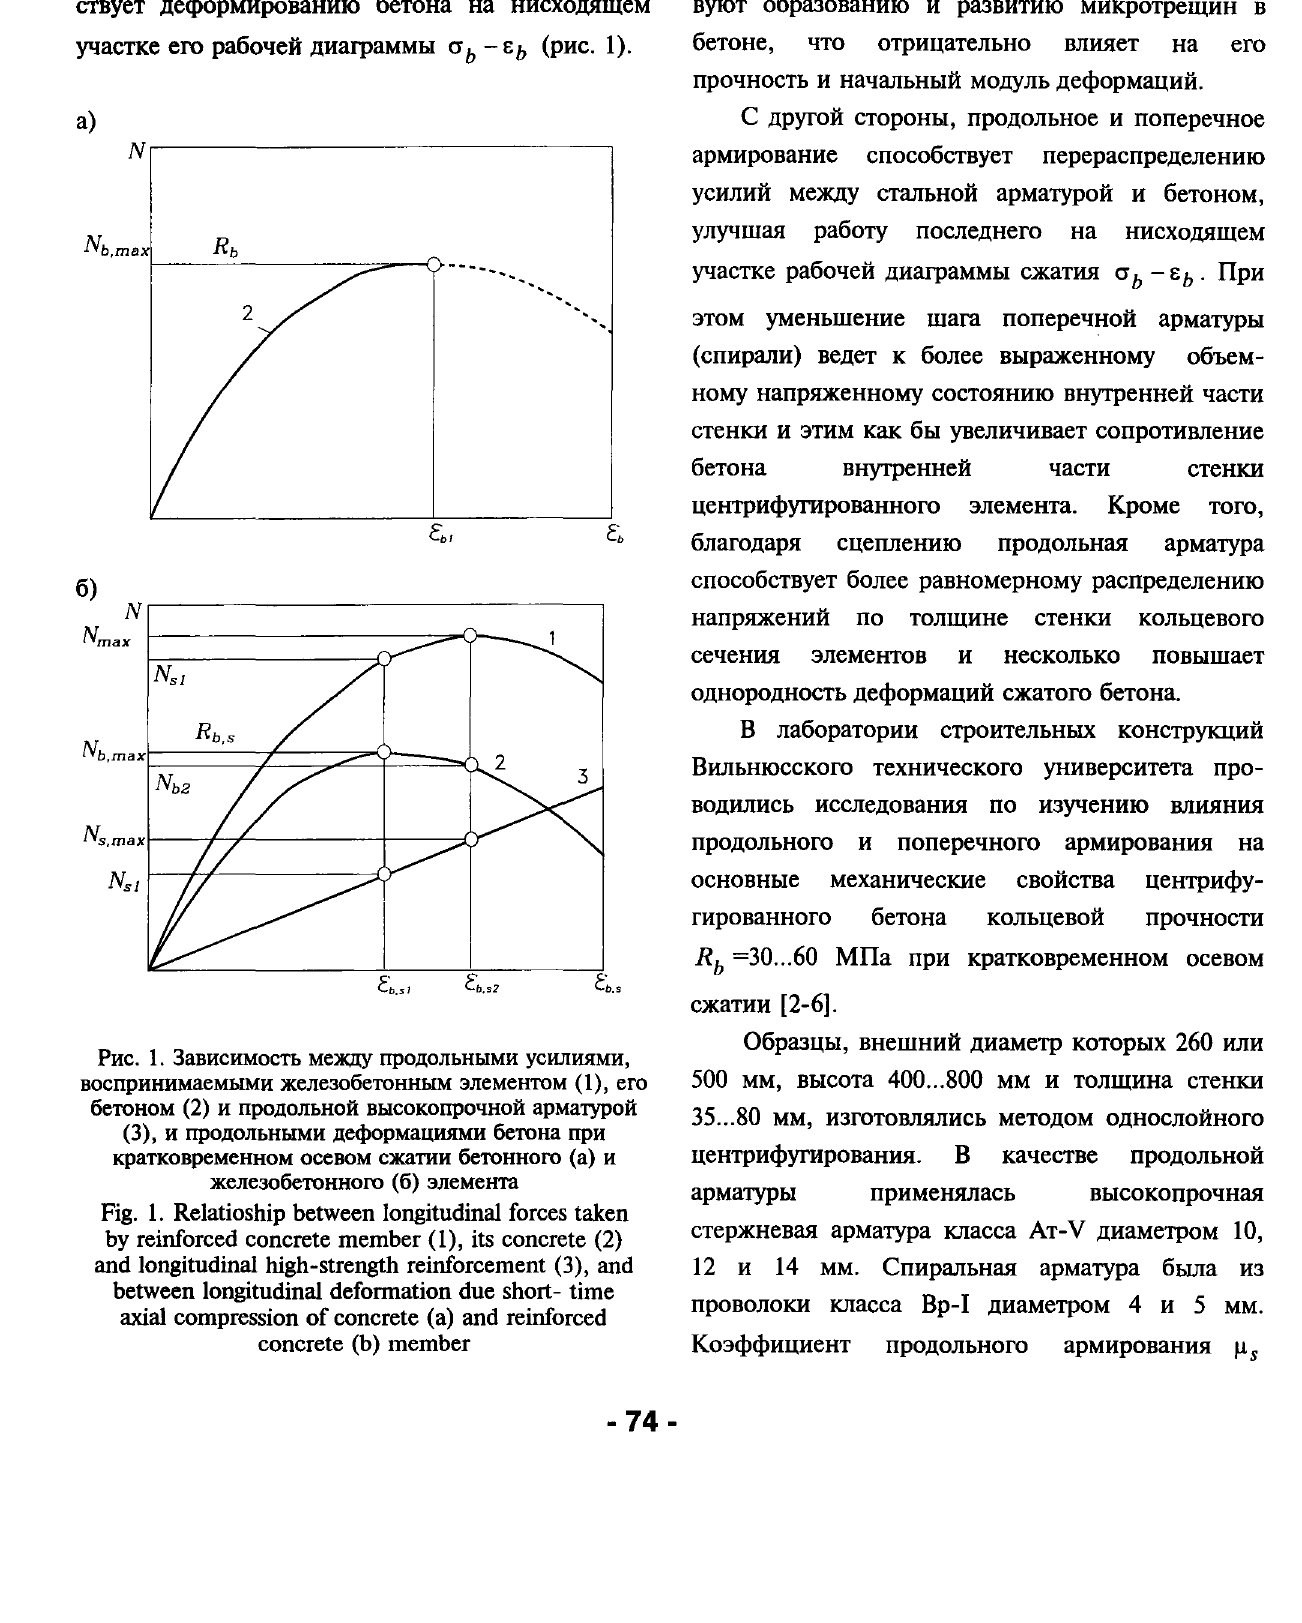
Fig. 1. Relatioship between longitudinal forces taken by reinforced concrete member (1), its concrete (2) and longitudinal high-strength reinforcement (3), and between longitudinal deformation due short- time axial compression of concrete (a) and